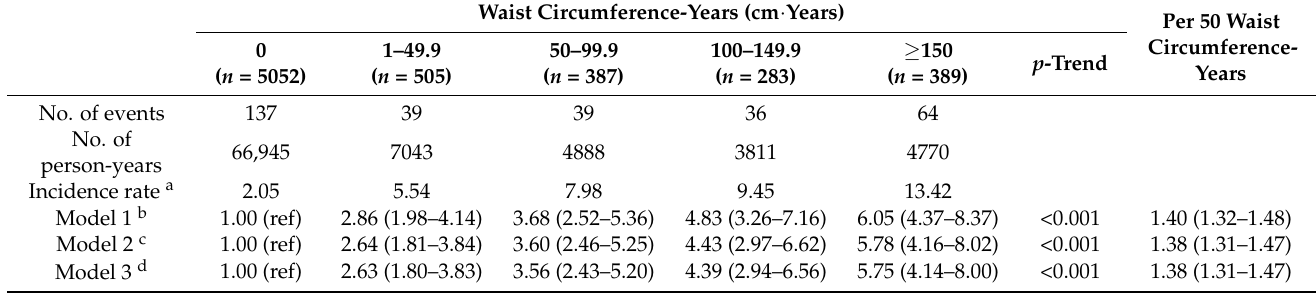
Table 2. The incidence, odds ratio, and 95% confidence interval for type 2 diabetes according to waist circumference-years.